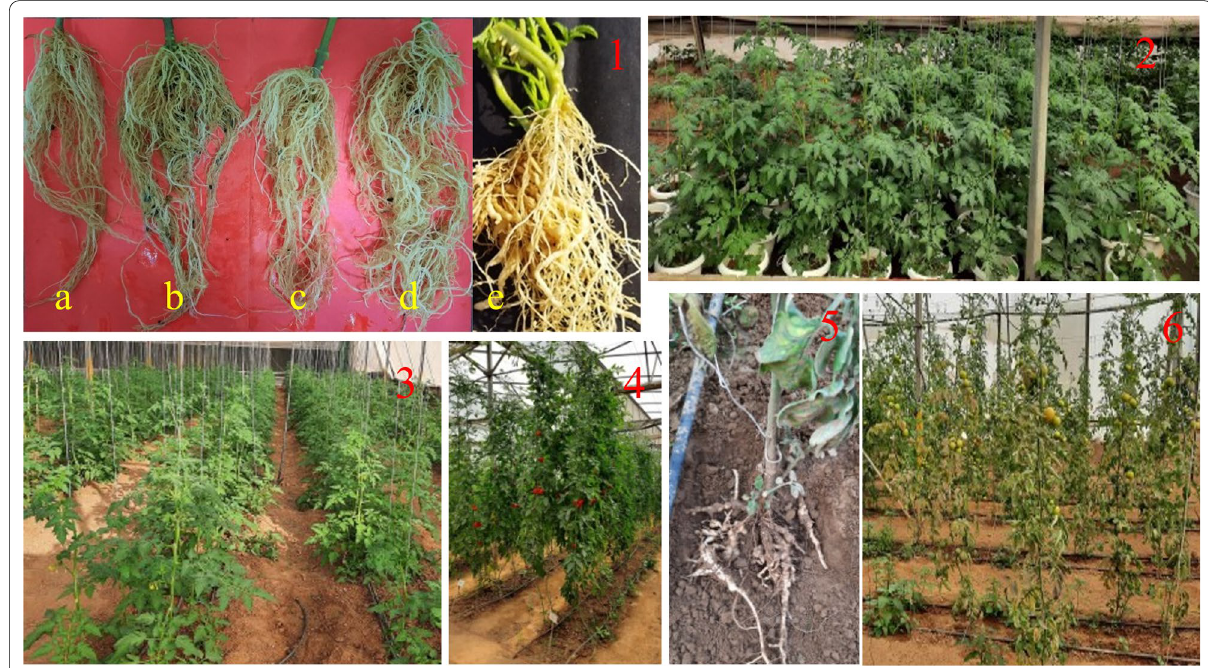
Fig. 1 1 Effect of PGPR isolates on gall formation in tomato cv. NS 4266 infected with M. incognita (Mi) . 1a Bacillus subtilis DTBS 5 amyloliquefaciens DSBA 11 Mi; 1c Pantoea agglomerans Mi; 1d Consortium Mi; 1e Untreated control (only Mi); 2: Enhanced plant growth + + + promotion in pot study; 3 , 4 PGPR treated tomato crop in polyhouse; 5 Heavily infested tomato root in protected cultivation of tomato; 6 Above ground symptoms of heavily infected tomato